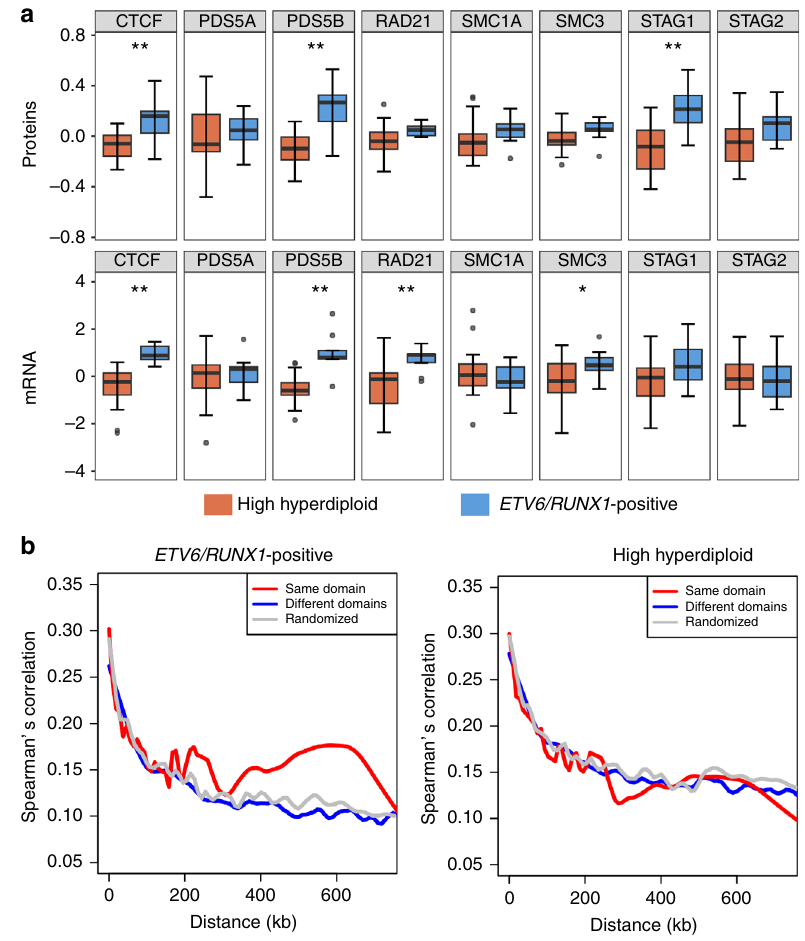
Fig. 4 Low CTCF/cohesin expression and transcriptional dysregulation in high hyperdiploid leukemia. a Boxplots of the expression of CTCF and members of the cohesin complex in proteomics (top) and RiboZero RNA-sequencing datasets (bottom). Low expression of CTCF/cohesin complex members was seen in the high hyperdiploid subgroup at both the RNA and protein levels. The center of the boxplot is the median and lower/upper hinges correspond to the fi rst/third quartiles; whiskers are 1.5 times the interquartile range and data beyond this range are plotted as individual points. b Spearman ’ s correlation coef fi cient between gene pairs as a function of distance across the oligo(dT) RNA-sequencing dataset for ETV6/RUNX1 -positive cases (left; n = 39) and high hyperdiploid ALL (right; n = 44). The analysis showed that the expression of gene pairs in the same topologically associating domain (TAD; red) displayed higher correlation than those in different domains (blue) or randomly selected regions (gray) in ETV6/RUNX1 -positive cases, whereas no difference was seen in high hyperdiploid ALL, suggesting that transcriptional dysregulation in hyperdiploid cases is related to TAD